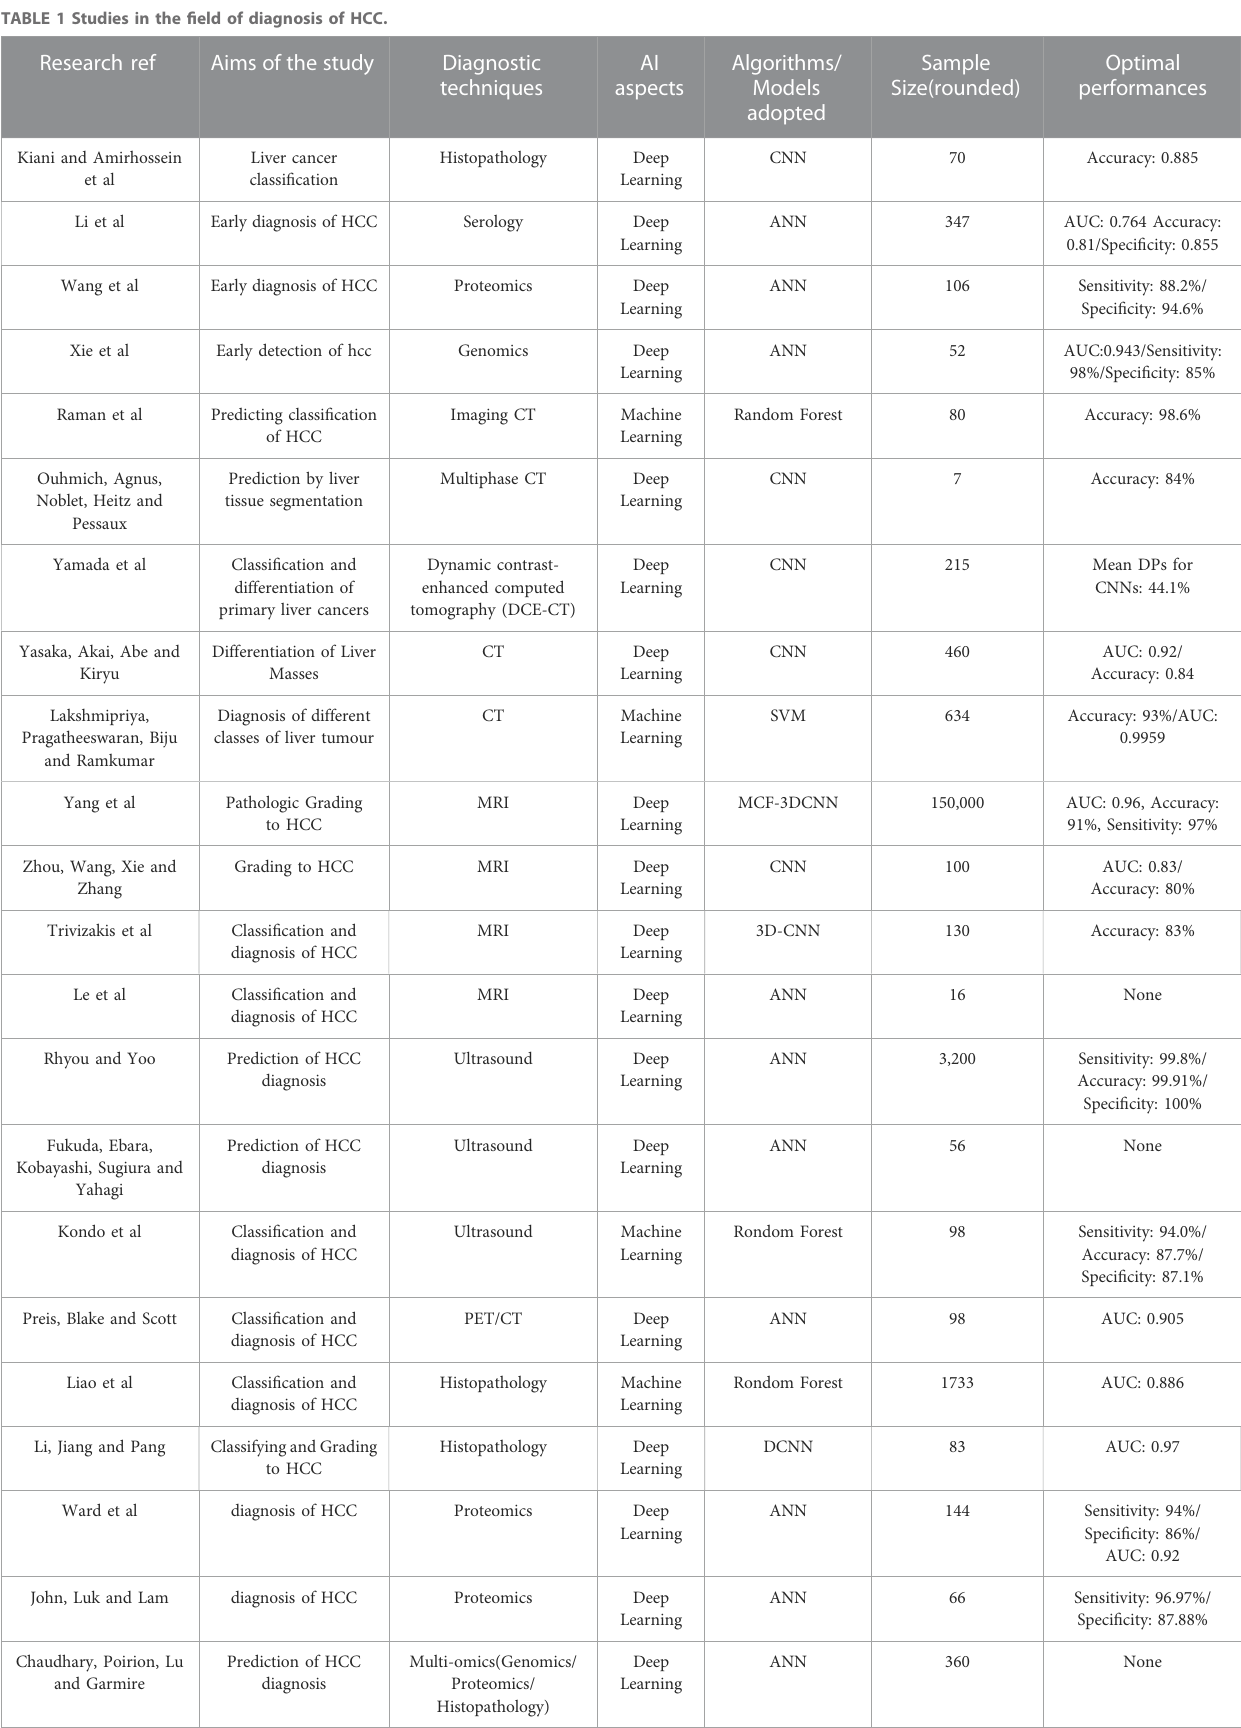
TABLE 1 Studies in the fi eld of diagnosis of